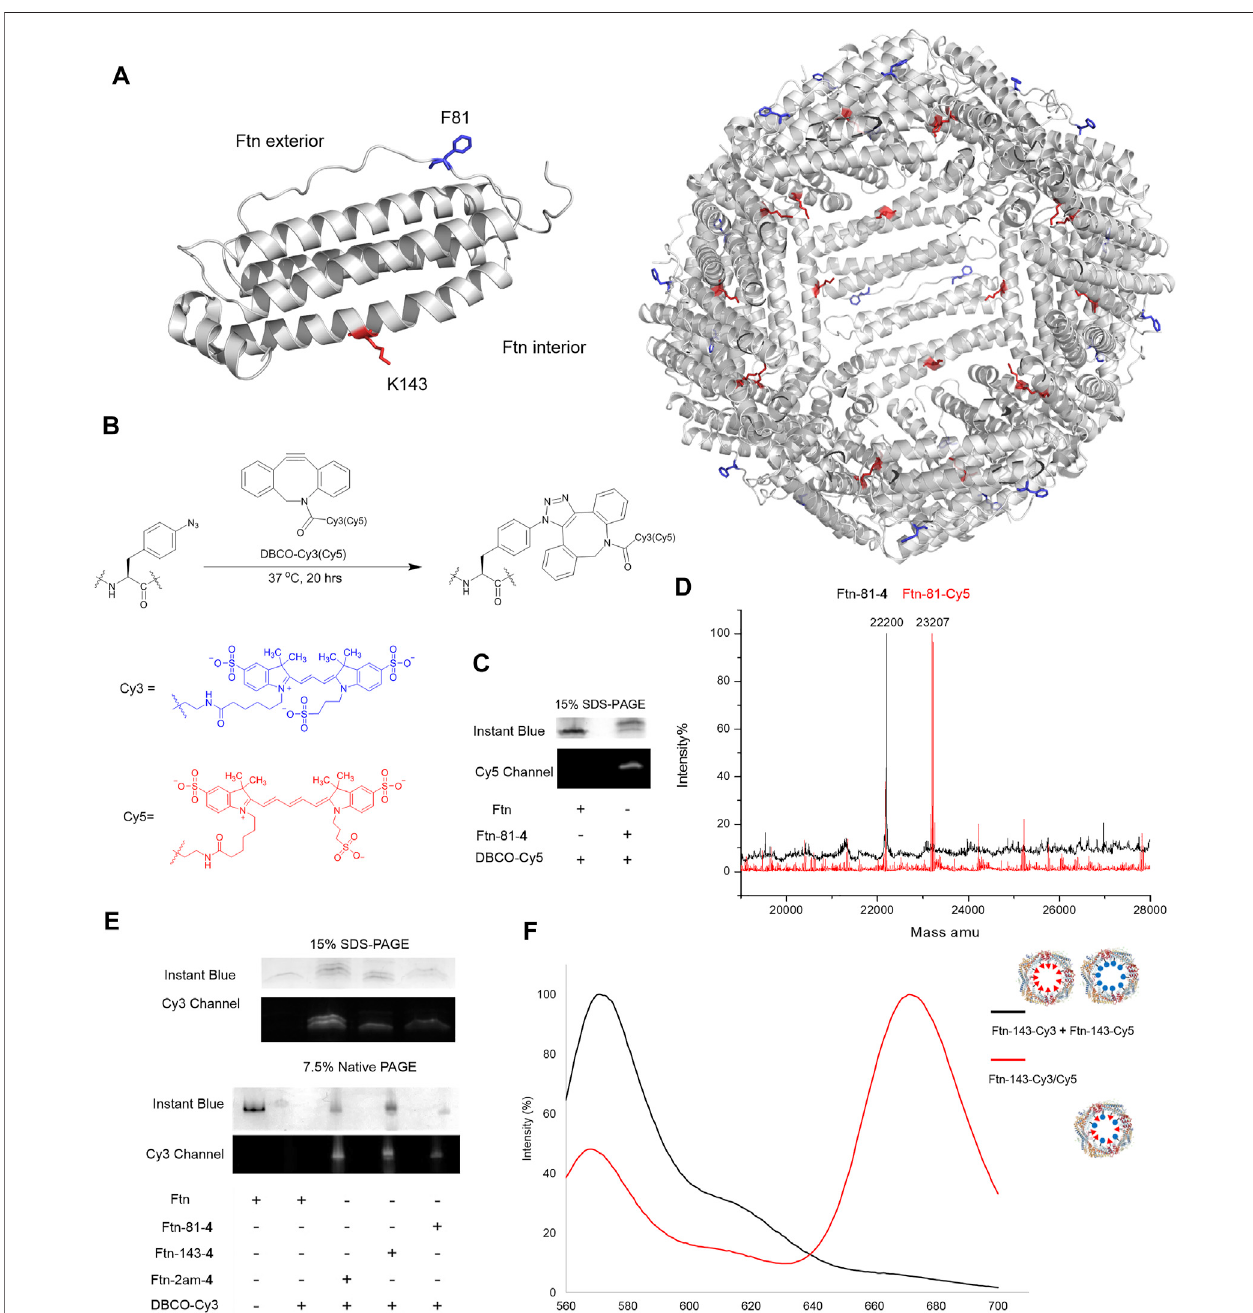
FIGURE 4 | Design of Ftn conjugates and click reaction study for the loading of Cy3 and Cy5. (A) Structure of Ftn monomer and the bisection of self-assembled 24mers. F81, facing the exterior of the Ftn nanoparticle, is shown in red stick; K143, facing the interior of the Ftn nanoparticle, is shown in blue stick. The PDB entry is 2FHA. (B) SynthesisschemeofSPAACforloadingDBCO-Cy3( λ ex / λ em (cid:2) 555/570 nm)andDBCO-Cy5( λ ex / λ em (cid:2) 640/664 nm)onFtn- 4 proteins. (C) SPAACofFtn-81- 4 and DBCO-Cy5. SDS-PAGE is visualized by Instant Blue staining and Cy5. (D) The deconvoluted ESI-MS spectra of Ftn-81- 4 and Ftn-81-Cy5. The calculated and found molecular weights are listed in Table 2 . (E) The SDS-PAGE and native PAGE analysis of Ftn-Cy3 conjugates. The gels are visualized by Instant Blue staining and Cy3 fl uorescence. Twenty micromolars of Ftn protein and 1 mM DBCO-Cy3 are reacted in room temperature for 4 h. (F) FRET analysis of Ftn-dye conjugates with the excitation at 550 nm. The black line denotes Ftn-143-Cy3 and Ftn-143-Cy3 protein mixture, whereas the red line denotes Ftn-143-Cy3/Cy5 protein.